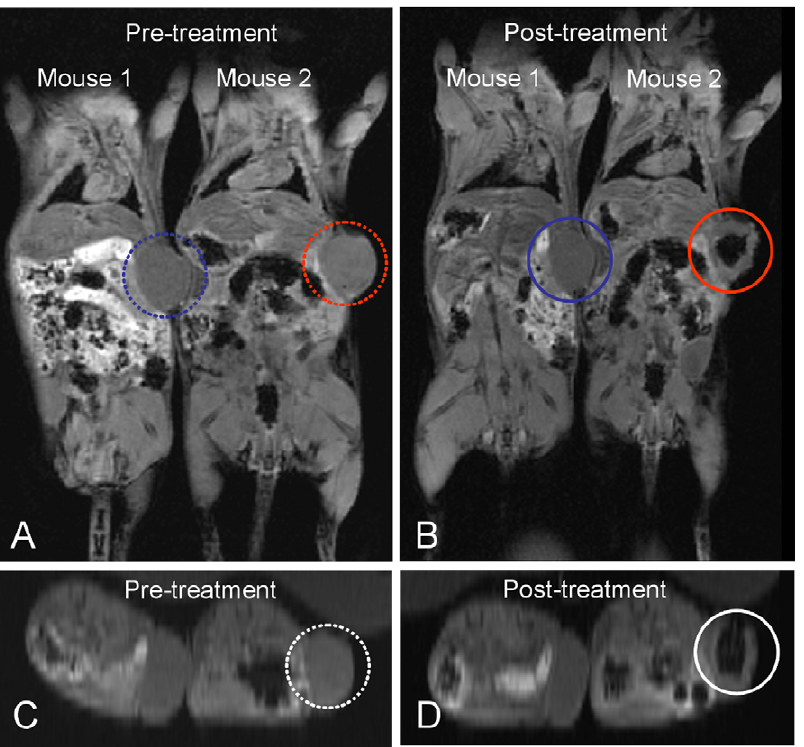
Figure 7. T2-weighted MR images of nude mice with breast tumor obtained (A) before and (B) after injection of MR contrast agent, obtained using a 3 Tesla MR scanner. Mouse 2 was injected with Mag@SiO2 nanoparticles as T2 contrast agent, while Mouse 1 was injected with saline as a control. Tumor sites in the control (mouse 1) and in the treated mouse (mouse 2) have been labelled as blue and red circles respectively. Panels C and D show the higher magnification transverse section images of tumor site corresponding to Panels A and B respectively, wherein tumor region injected with MR contrast agent has been highlighted using white circles.